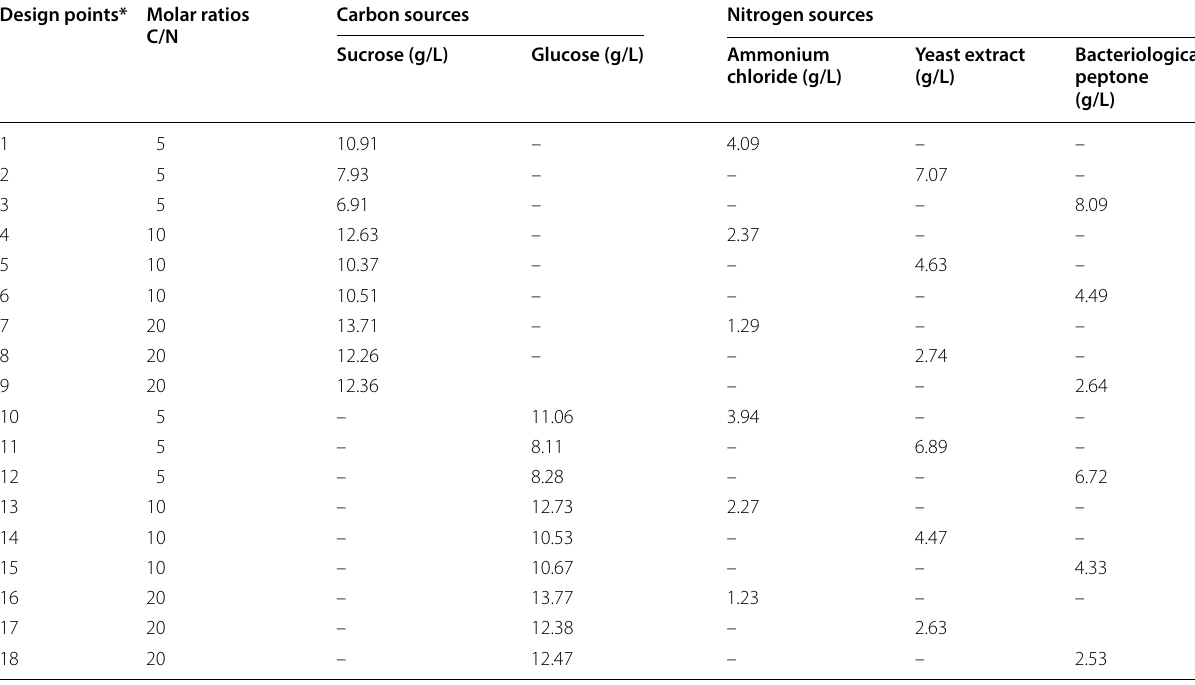
Table 1 Experimental design for the evaluation of different carbon and nitrogen sources, as well as their molar ratios on P. indica H32 growth Design points* Molar ratios